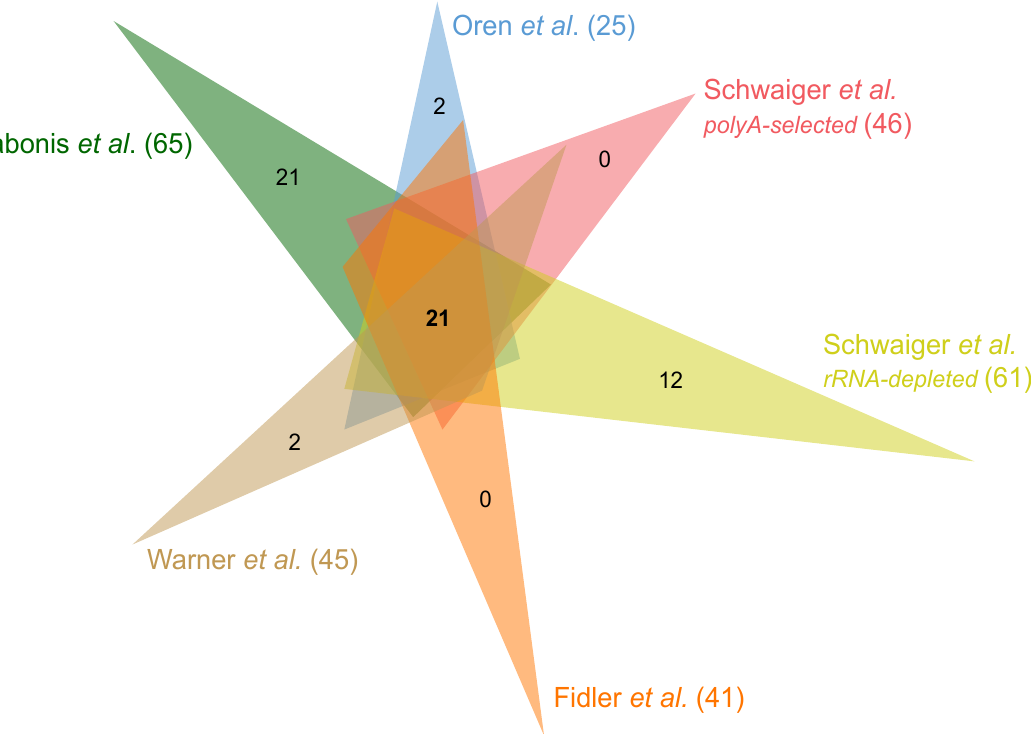
Figure 3. Venn diagram of core viral sequences for all non-embryonic datasets [31,33–36] revealed by remapping filtered reads to the viral contigs assembled from the merged dataset. For simplicity, only numbers of contigs common to all datasets and specific to each dataset are shown. Values in brackets indicate the total number of di ff erent viral contigs to which reads from each dataset were successfully